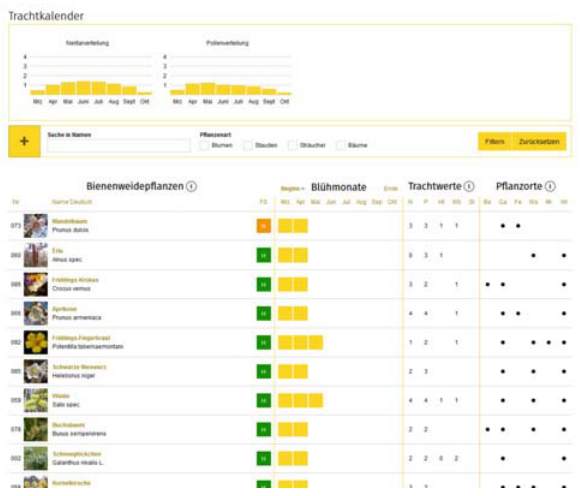
Figure 10: Plant catalogue in the Web-portal (www.trachtfliessband.de) – Screenshot of a tabular view with bee-flowers sorted for month of blooming (Source: Bernhard and Boris Willi).